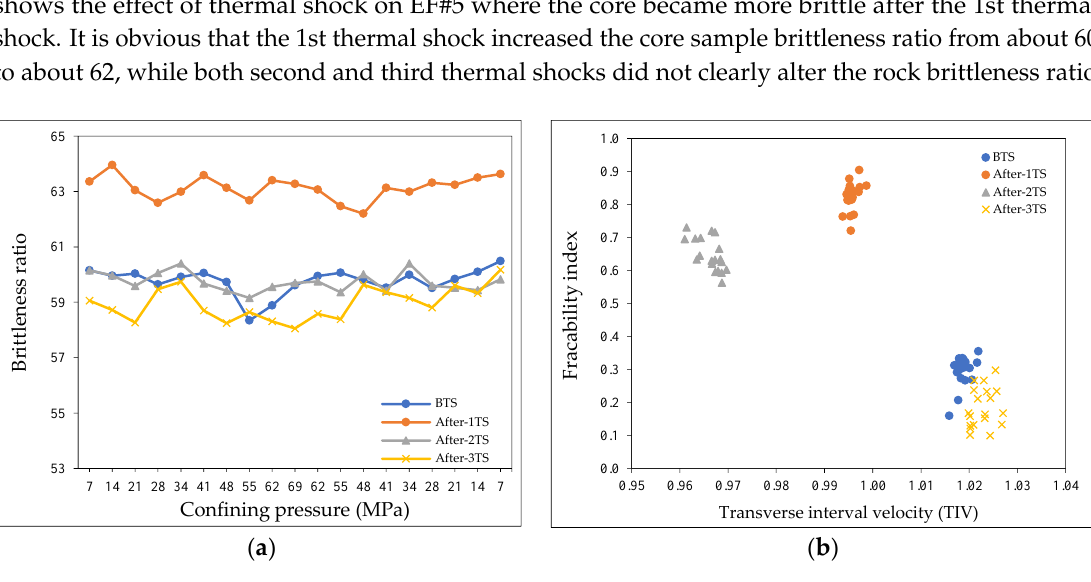
Figure 9. ( a ) Brittleness ratio results of EF#5 at different confining pressures before and after thermal shock; and ( b ) fracability index of EF#5 vs. transverse interval velocity (TIV) before and after thermal shock.